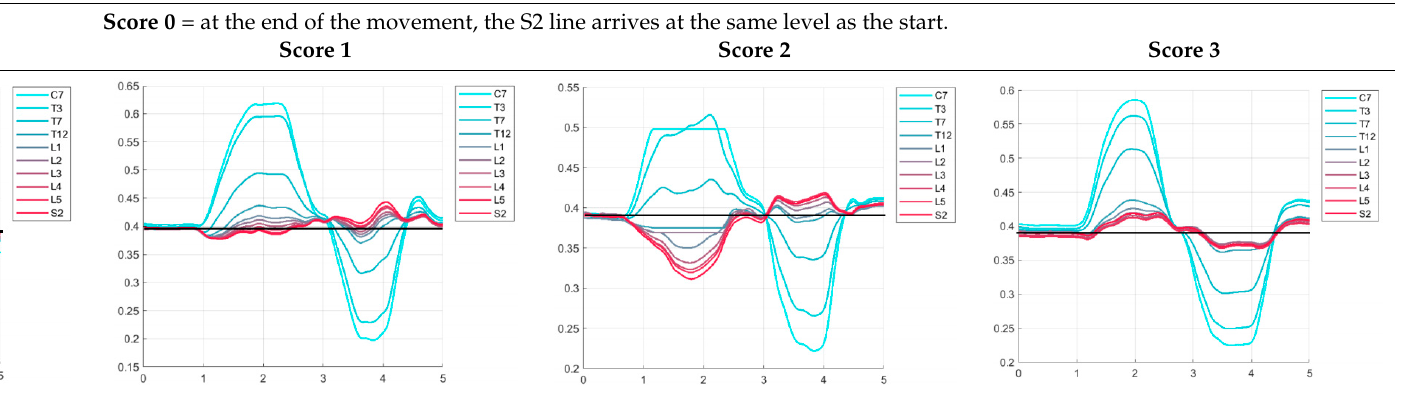
Score 0 = pelvis centre should be aligned with the midpoint of each line of the graph.